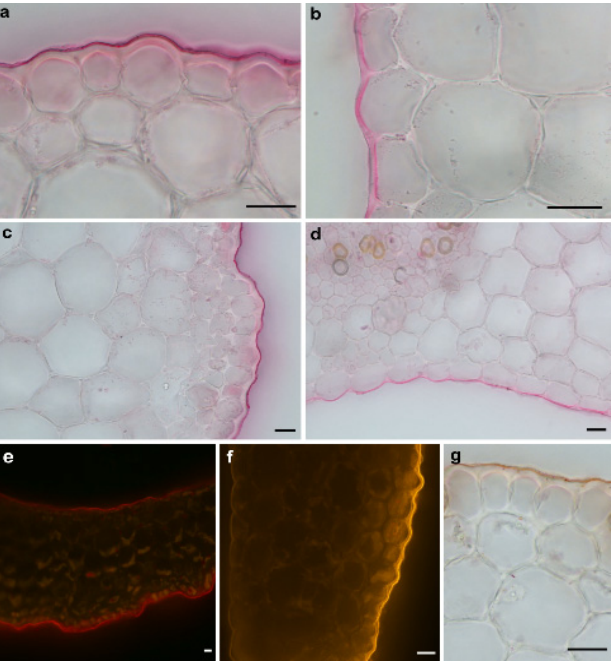
Figure 2. Light microscopy photographs of the cross-sections of the maize coleoptile segments ( Zea mays L.) that had been stained with the lipophilic dyes in order to visualise the cuticle. ( a , c ) and ( b , d ) The cuticle on the outer and inner epidermis of the coleoptile segments that had been stained with Sudan Red 7B under a bright field microscope, respectively. ( e , f ) After Sudan IV and Nile Red staining under an epifluorescence microscope. The cuticle was observed as a continuous bright red layer or orange-gold, respectively, on both the outer and inner epidermal surfaces. ( g ) Sudan IV rapid routine staining to identify the cuticle on the outer epidermal surface. Scale bars: ( a – g ) 20 µm.